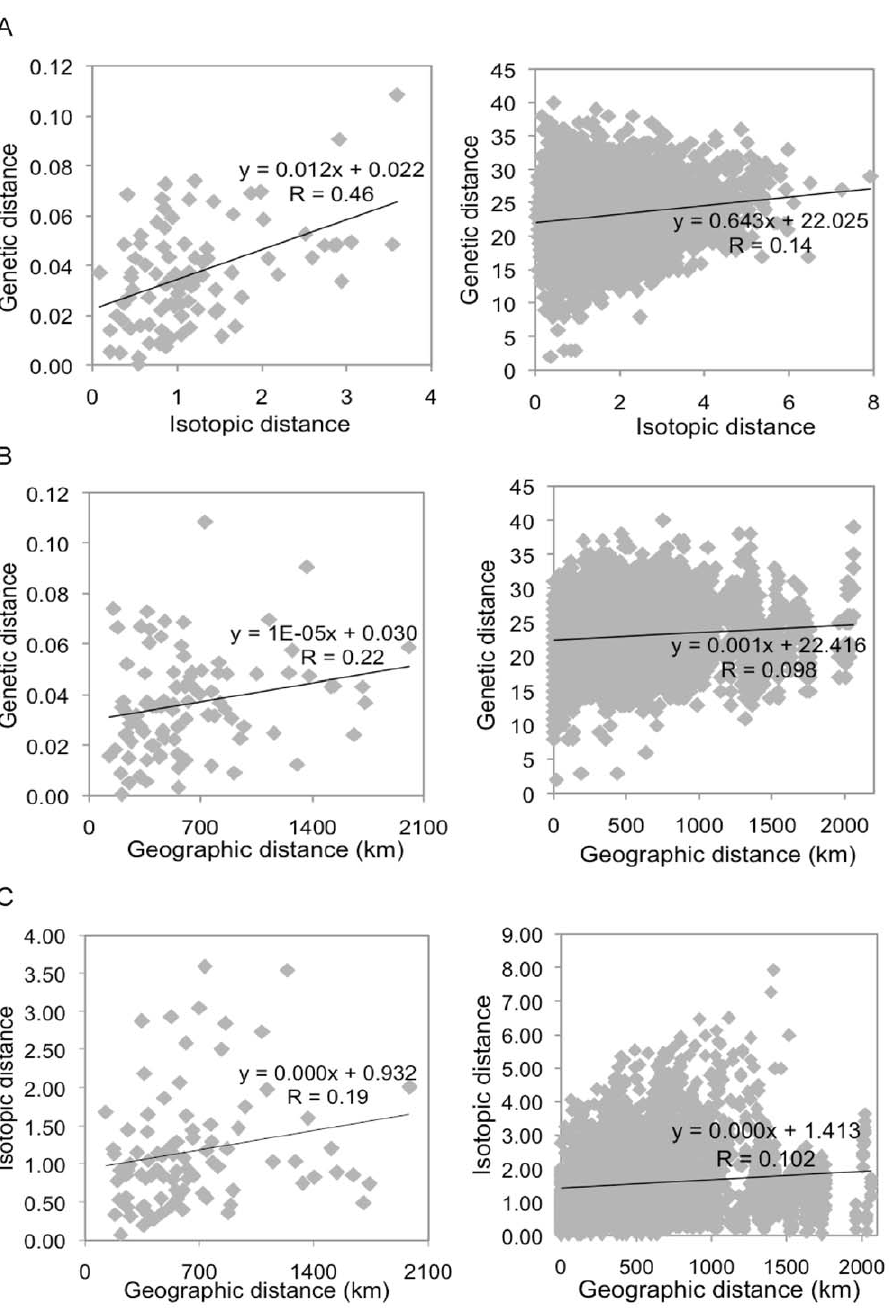
Figure 3. Graphical illustration of correlations between genetic and dietary differentiation and geographic distance. Correlations are presented at a population (left) and individual (right) level. (A) The correlation between genetic and stable isotope differentiation. Genetic distances between populations were represented by pairwise F ST values. Genetic distances between individuals were calculated using a method implemented in GenAlEx. Isotopic distances between populations and individuals were calculated by treating d 13 C and d 15 N values as two-dimensional Cartesian coordinates. Both correlations are significant (see Results). (B) The correlation between genetic and geographic distances. Only the correlation at individual level is significant ( P =0.04). (C) Correlation between stable isotope differentiation and geographic distances. Subpopulation MIT4 was represented by only one individual, and it was excluded from the population-level analysis.